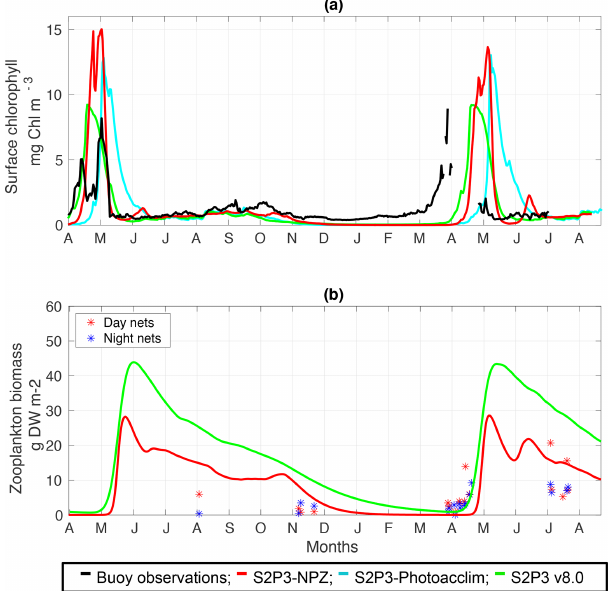
Figure 3. (a) SSB observations of surface chlorophyll a (black line), along with the modelled surface chlorophyll a for the S2P3-NPZ (red line), S2P3-Photoacclim (cyan line), and S2P3 v8.0 (green line) calibrated models. (b) Observations of zooplankton biomass pre- sented as discrete points for day nets (red dots) and night nets (blue dots) taken during the cruises DY026, DY018, DY029, and DY033; modelled zooplankton biomass from the S2P3-NPZ (red line) and S2P3 v8.0 (green line) calibrated